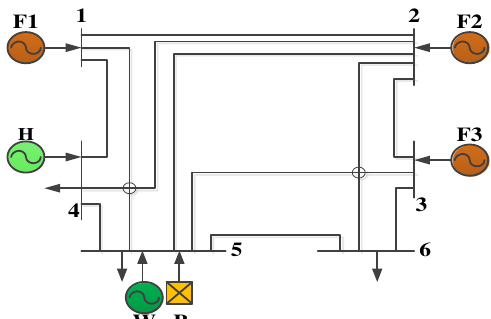
Fig. 4 Modified 6-bus system with wind farm, pumped-storage and battery-storage